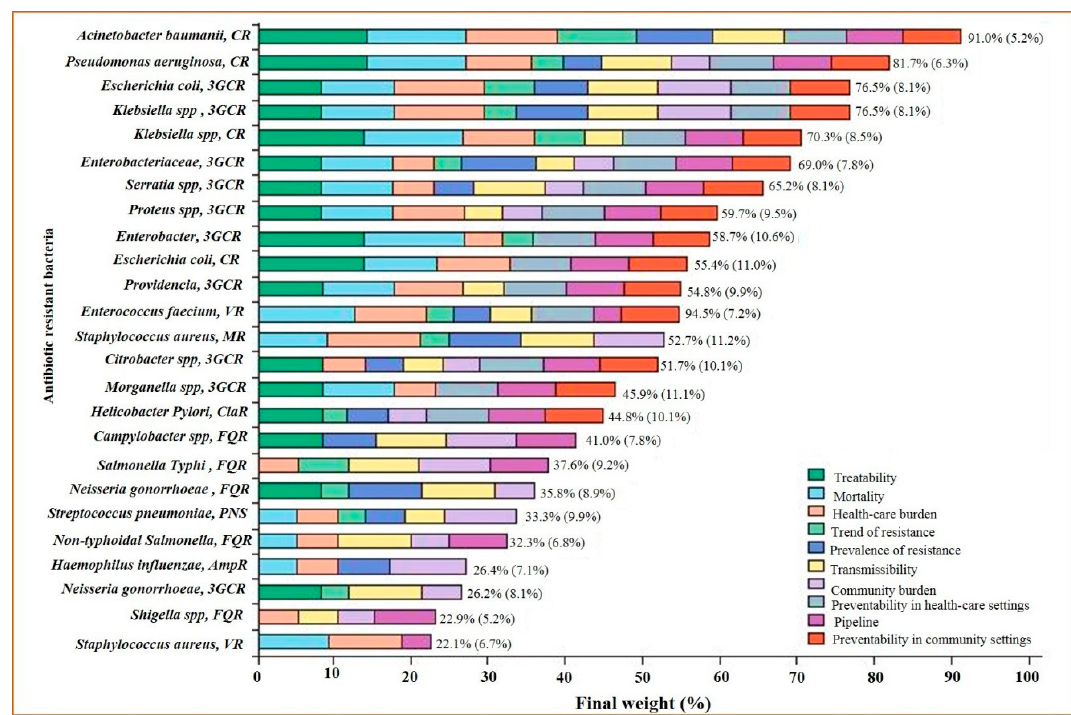
Figure 1. Representation of the final ranking of antibiotic-resistant bacteria, adapted with permission from Tacconelli et al. [11]. CR = carbapenem resistant. 3GCR = third-generation cephalosporin resistant. VR = vancomycin resistant. MR = meticillin resistant. ClaR = clarithromycin resistant. FQR = fluoroquinolone resistant. PNS = penicillin non-susceptible. AmpR = ampicillin resistant.